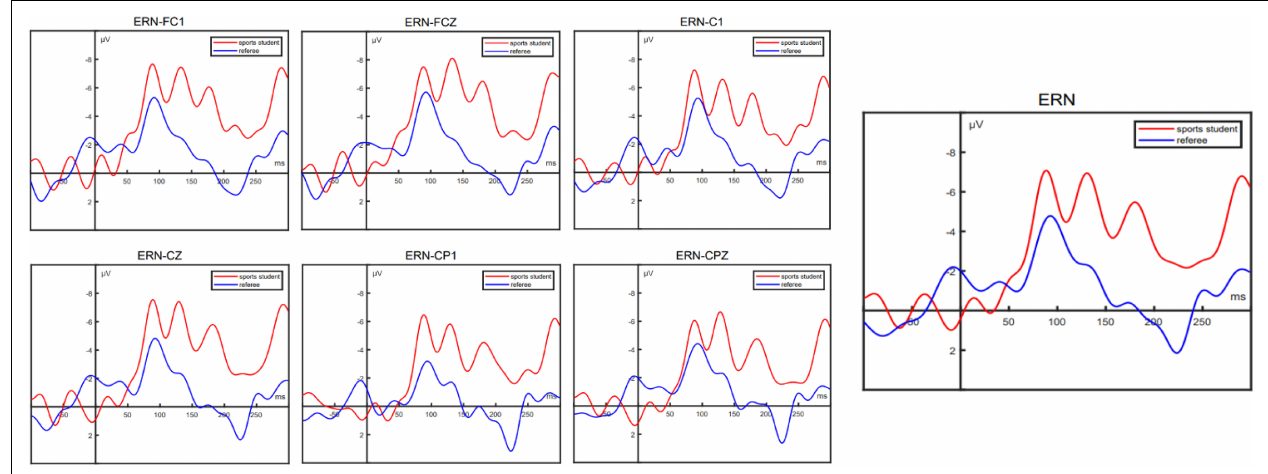
FIGURE 4 | Average amplitude map of ERN at 6 electrode points of two groups.